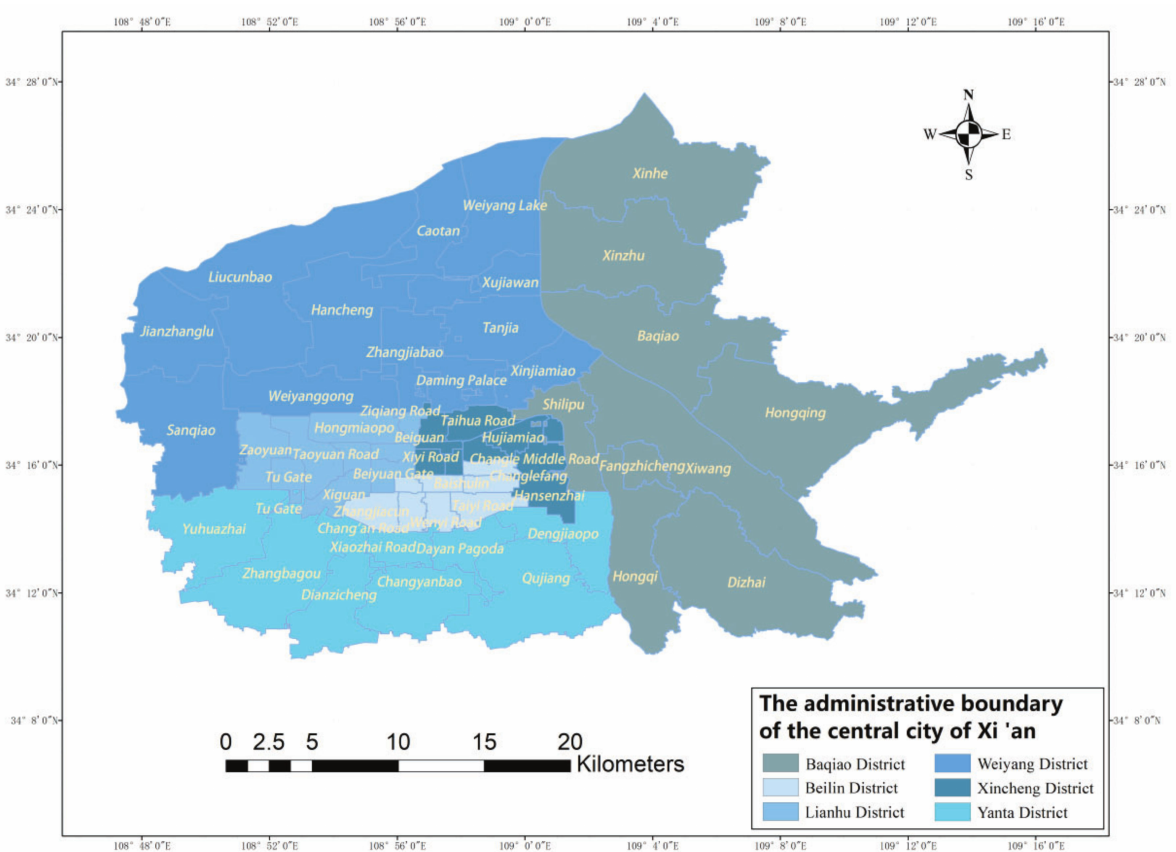
Figure 1. The administrative boundary of the central city of